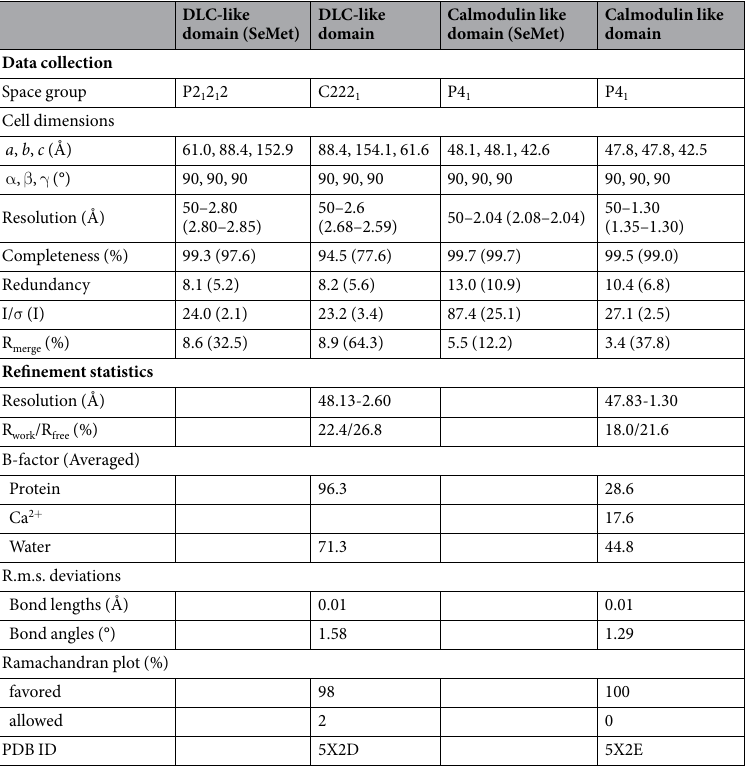
Table 1. Data collection and refinement statistics for CsTAL3. Highest resolution shell is shown in